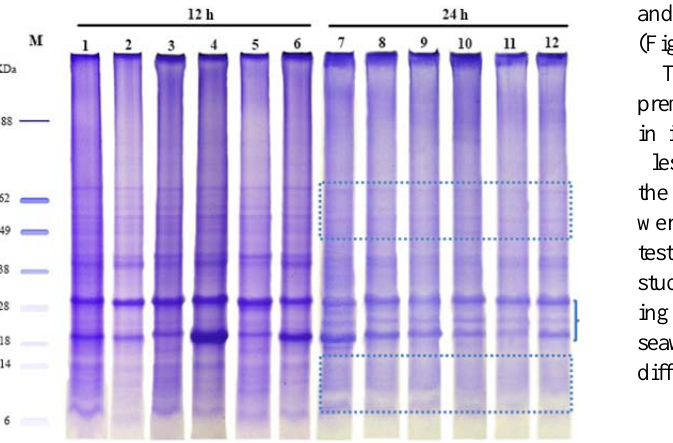
Fig. 9. SDS-PAGE of mix gills protein samples from B. azoricus , incubated in the presence of Seawater, V. splendidus , V. alginolyti- cus , V. anguillarum , pool of Vibrio and Flavobacterium . The lanes 1, 2, 3, 4, 5 and 6 represent samples at 12h infection and the lanes 7, 8, 9, 10, 11 and 12 correspond to 24h infection samples. The rect- angles boxes and braces indicate the main differences in protein pat- terns (18kDa) between 12h and 24h of infection. Molecular mass marker (M, SeeBlue ® ) is